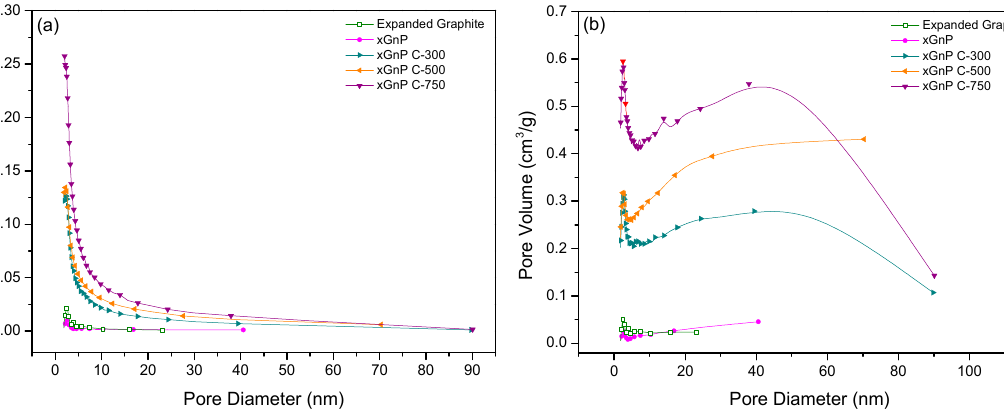
Figure 2. Adsorption–desorption isotherms of N 2 at 77 K: ( a ) adsorption and ( b ) desorption.